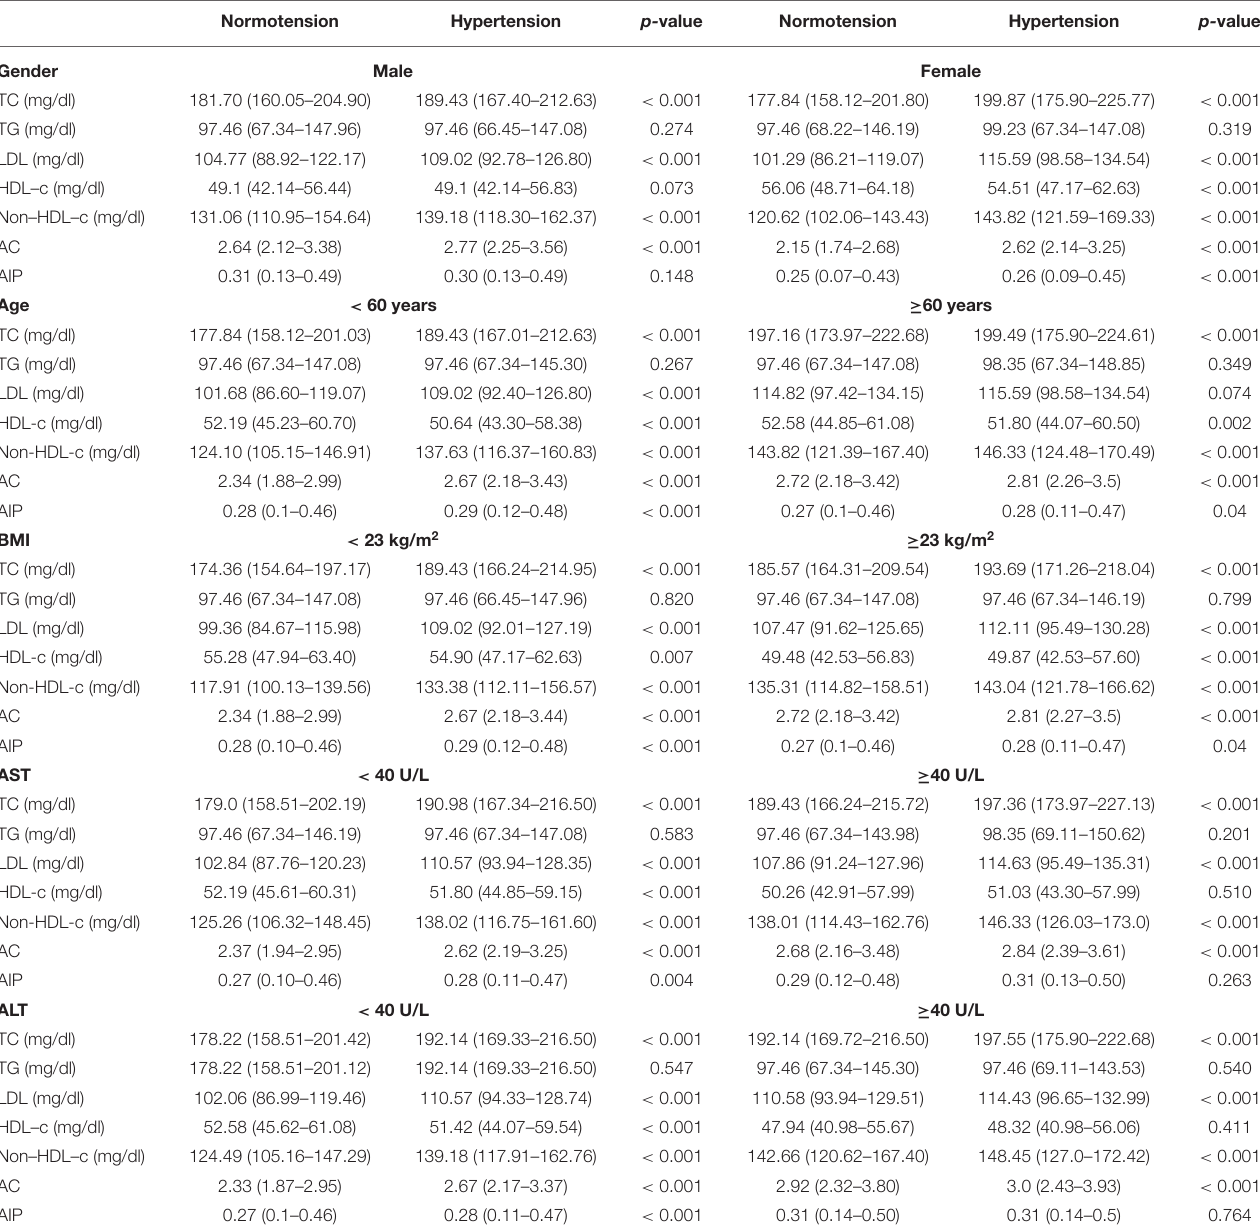
TABLE 2 | Subgroup analysis of differences in lipid profiles and atherosclerotic indices between normotension and hypertension according to gender, age, BMI, AST, and ALT*. Normotension Hypertension p- value Normotension Hypertension p-